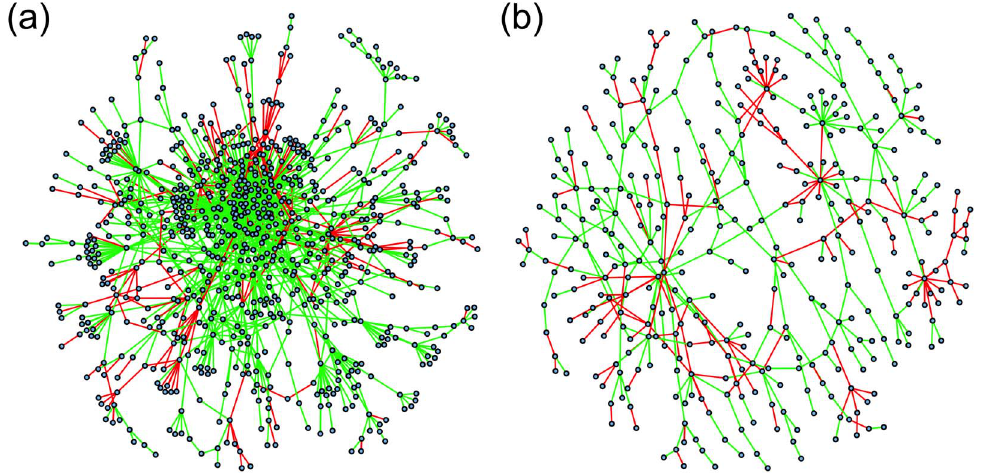
Figure 4. Larger significant subnetworks: network diagrams. Network edges displayed in green and red indicate positive and negative hazard ratios, respectively, for the DNAm network correlation measure corresponding to that interaction; these correspond, respectively, to an increase and decrease in ‘network interaction co-ordinatedness’ for worse disease prognosis. (a) the KIRC large subnetwork. (b) the LUAD large subnetwork. Further details about the corresponding network nodes (genes) for the top 5% of the degree distribution and top 25 significantly enriched gene sets appear in tables S5–6.